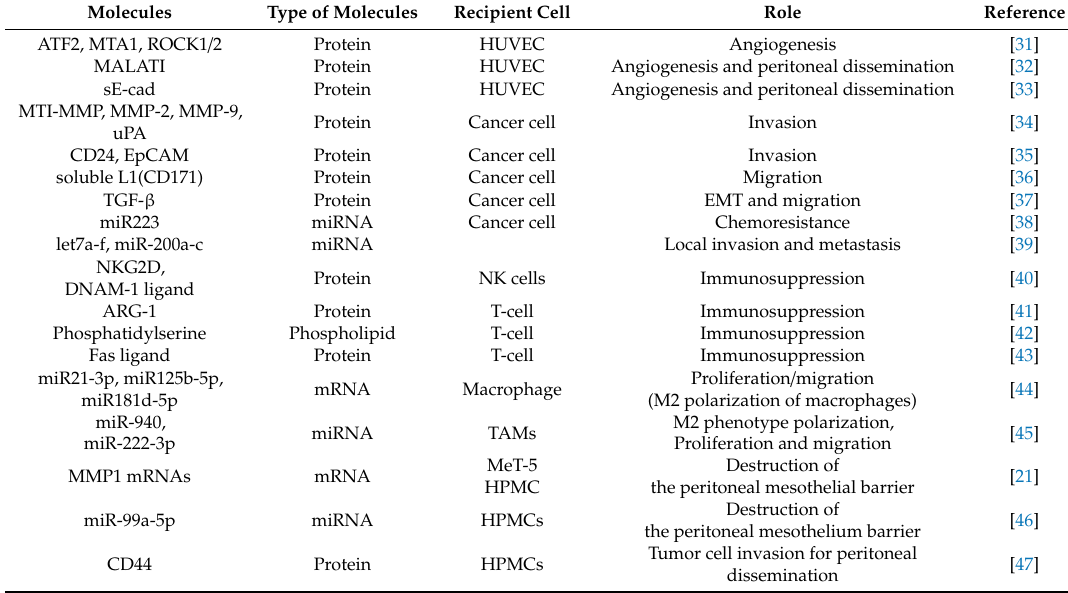
Table 1. Biomolecules included in exosomes and their role in the progression of ovarian cancer.